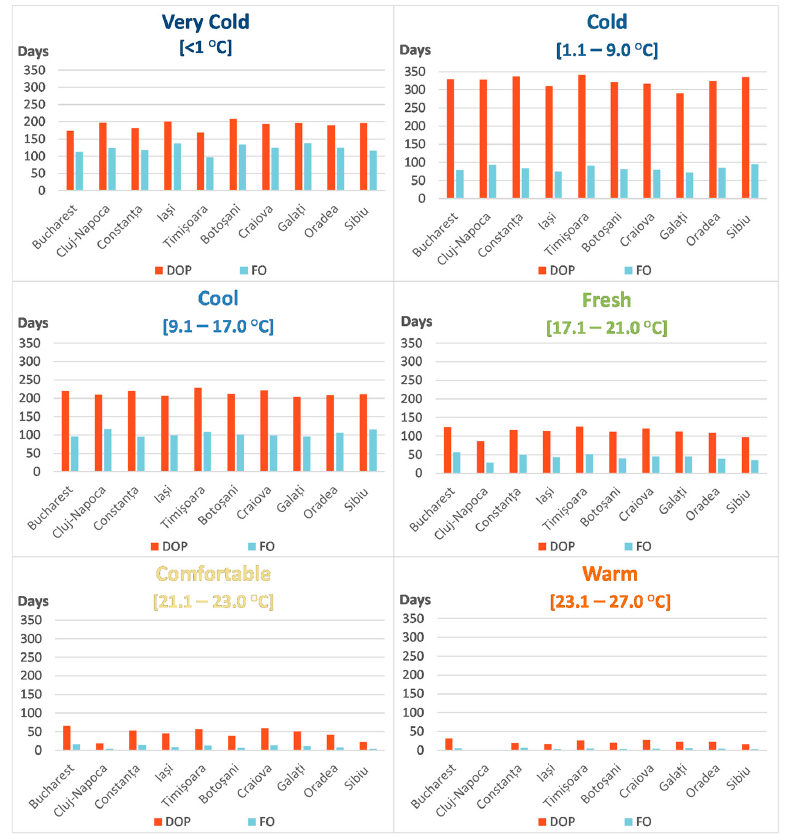
Figure 5. DOP and FO for TE index by thermal sensations classes and weather stations (number of days).